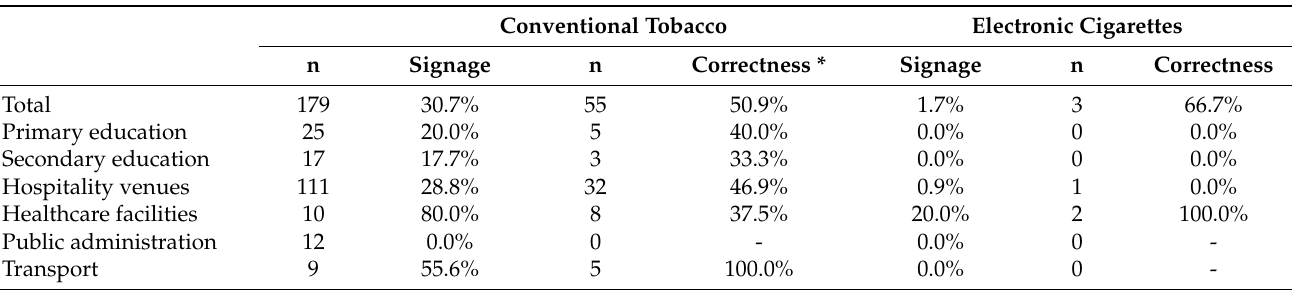
Table 1. Percentages of exterior smoke-free zone signage and correctness on the doors of public establishments for conventional tobacco and electronic cigarette